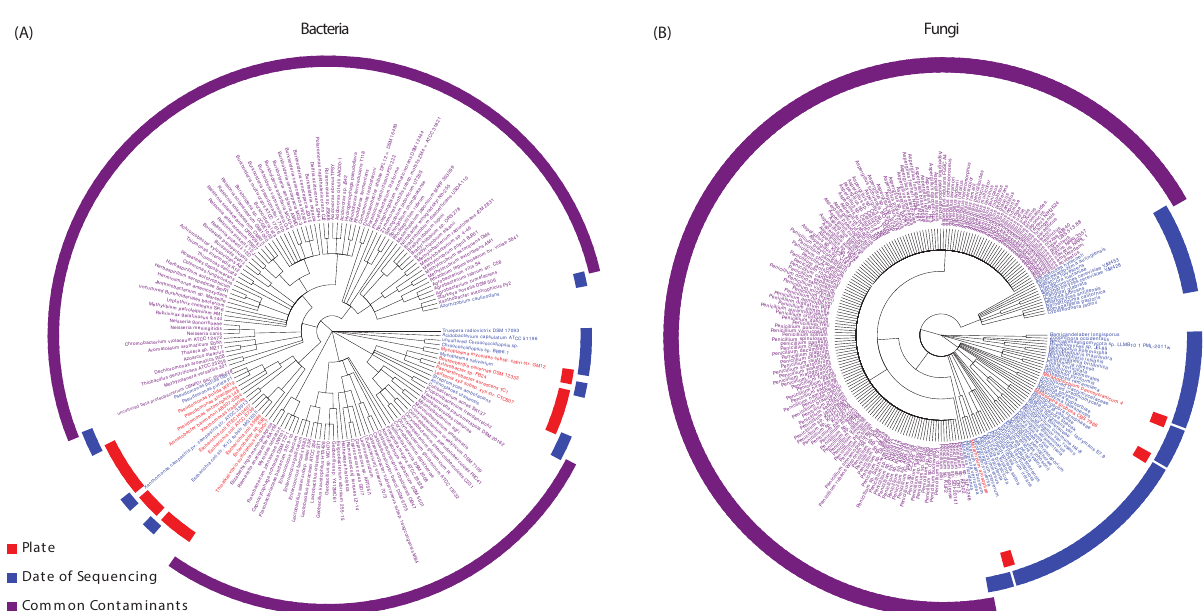
Figure 2. Identification of potential contaminants introduced through the sequencing process. Poten- tial microbial contaminants were identified and removed from further analysis using three contami- nation correction methods: irregular microbe counts present on specific sequencing plates, irregular microbe counts on specific dates, and commonly known hospital and sequencing contaminants from the literature. ( A ) Potential bacteria contaminants, ( B ) Potential fungal